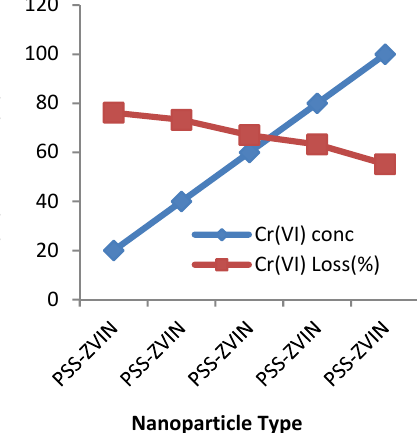
Fig.10.The removal efficiency of Cr(VI) using PVP- ZVINs as a function of Cr(VI) concentrations